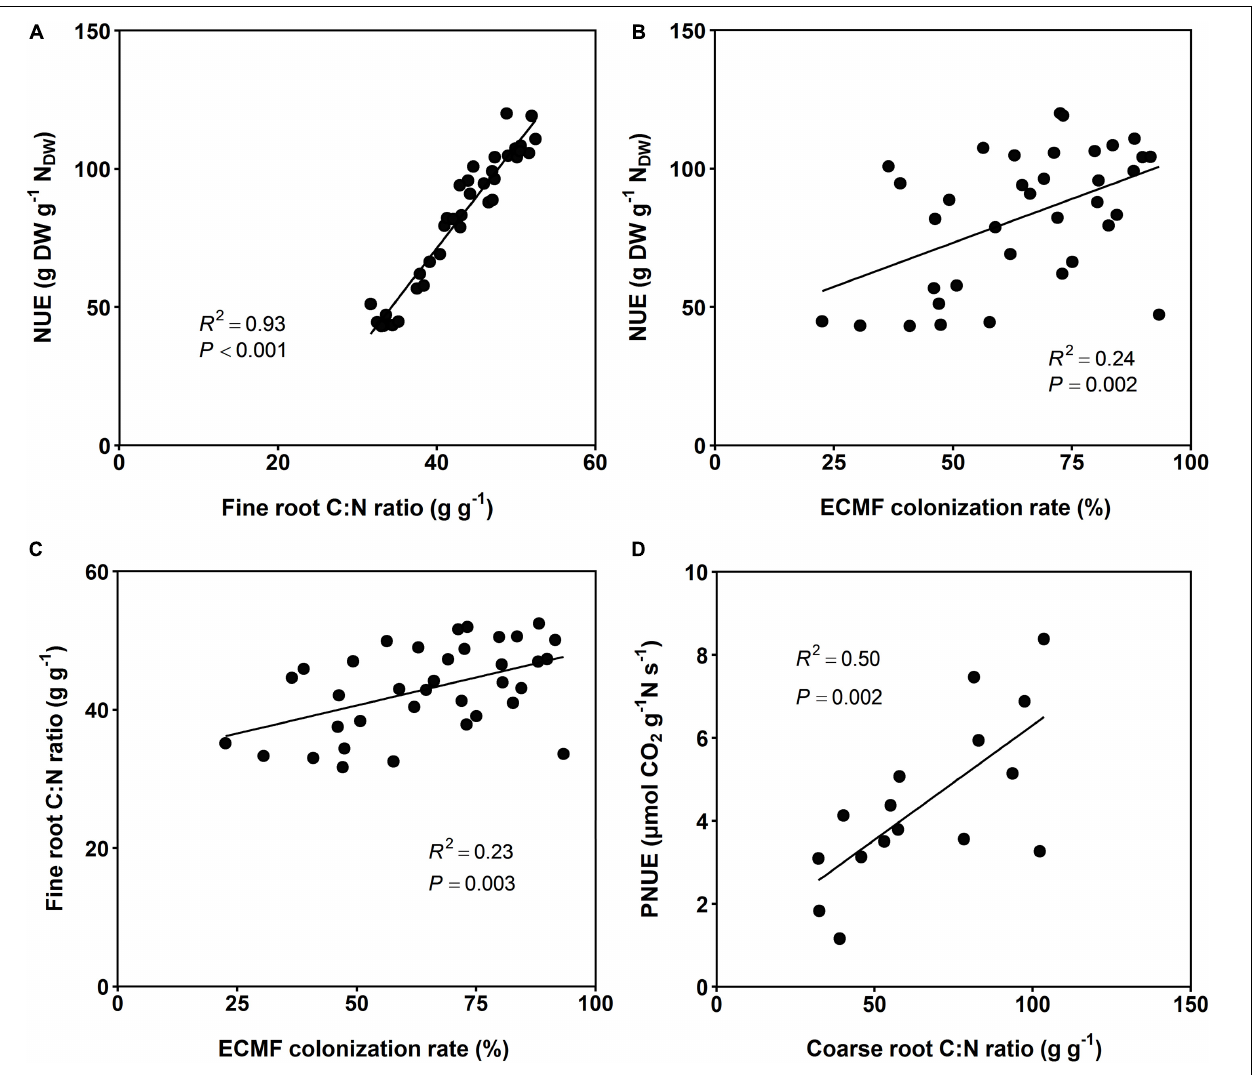
FIGURE 3 | (A) Linear regressions between N use efficiency (NUE) and fine root C:N ratio, (B) between NUE and ECMF colonization rate, (C) between fine root C:N ratio and ECMF colonization rate, and (D) between photosynthetic N use efficiency (PNUE) and coarse root C:N ratio of European beech saplings grown at increasing soil N:P ratios and climate change conditions ( n = 36 treatments; (A) NUE = -77.7 + 3.72 × fine root C:N ratio; (B) NUE = 41.5 + 0.63 × ECMF colonization rate; (C) Fine root C:N ratio = 32.5 + 0.16 × ECMF colonization rate; (D) PNUE = 0.8 + 0.06 × coarse root C:N ratio). Shown are the means of all 36 treatments (for PNUE only 16 treatments). All slopes are significant, as well as the intercepts for the relationships between NUE and fine root C:N ratio, between NUE and ECMF colonization rate, and between fine root C:N ratio and ECMF colonization rate. The intercept for the relationship between PNUE and coarse root C:N is not significant ( P =